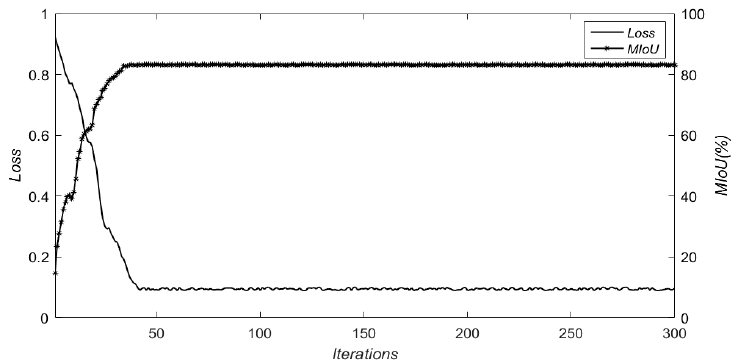
Figure 7. The iteration loss and MIoU of the Front-end+Large network.